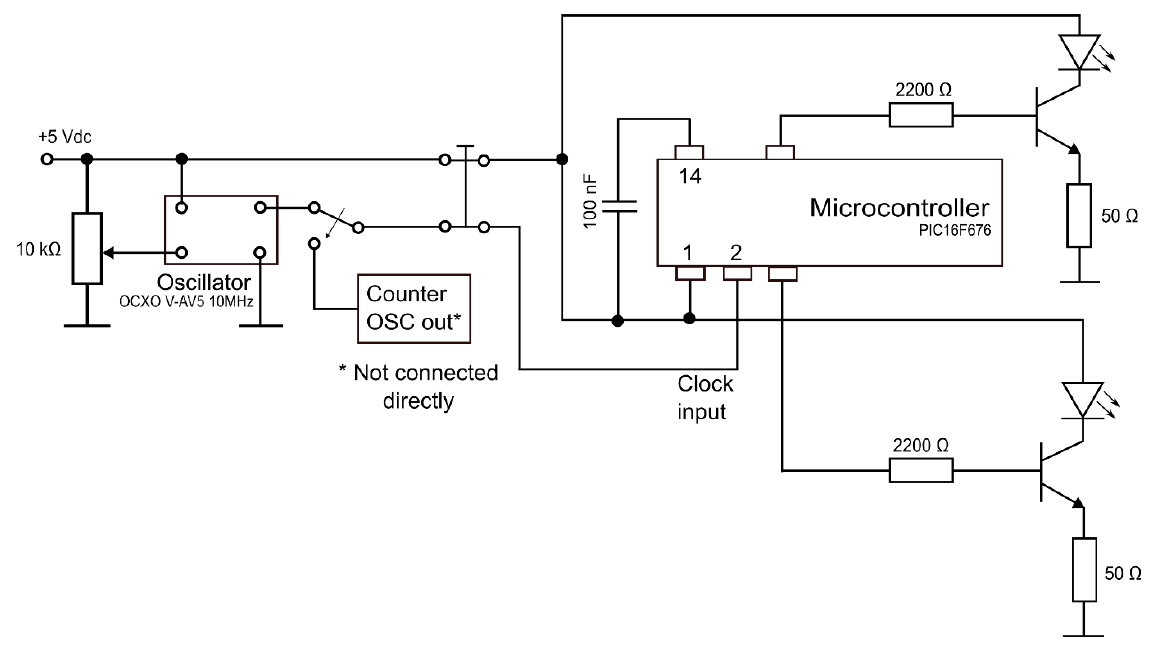
Figure 3. Electrical schematic of the device.